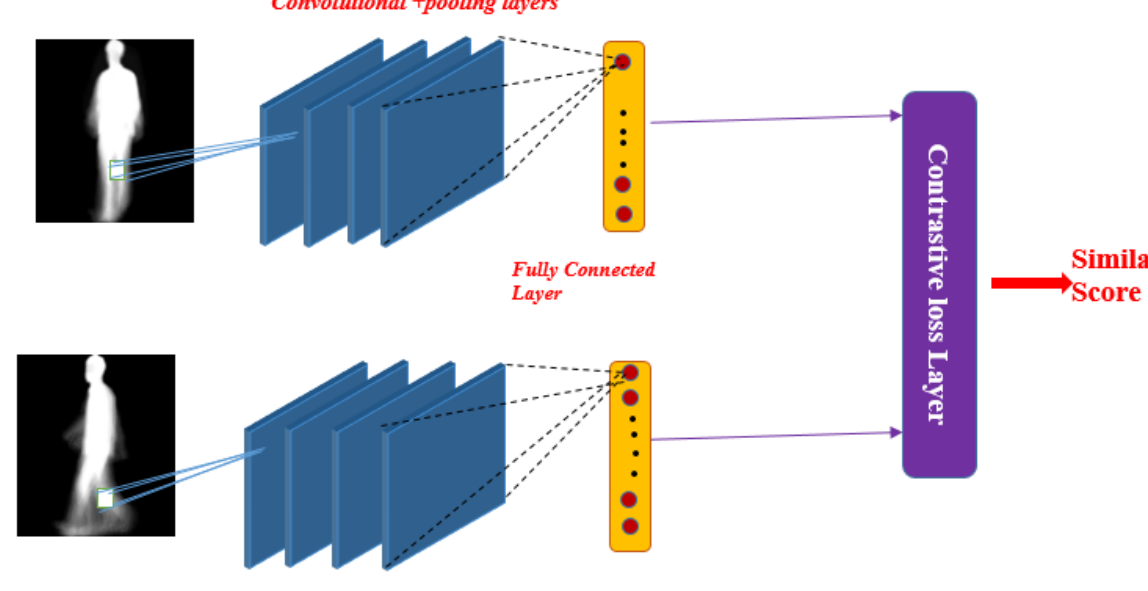
Figure 2. Gait Verification